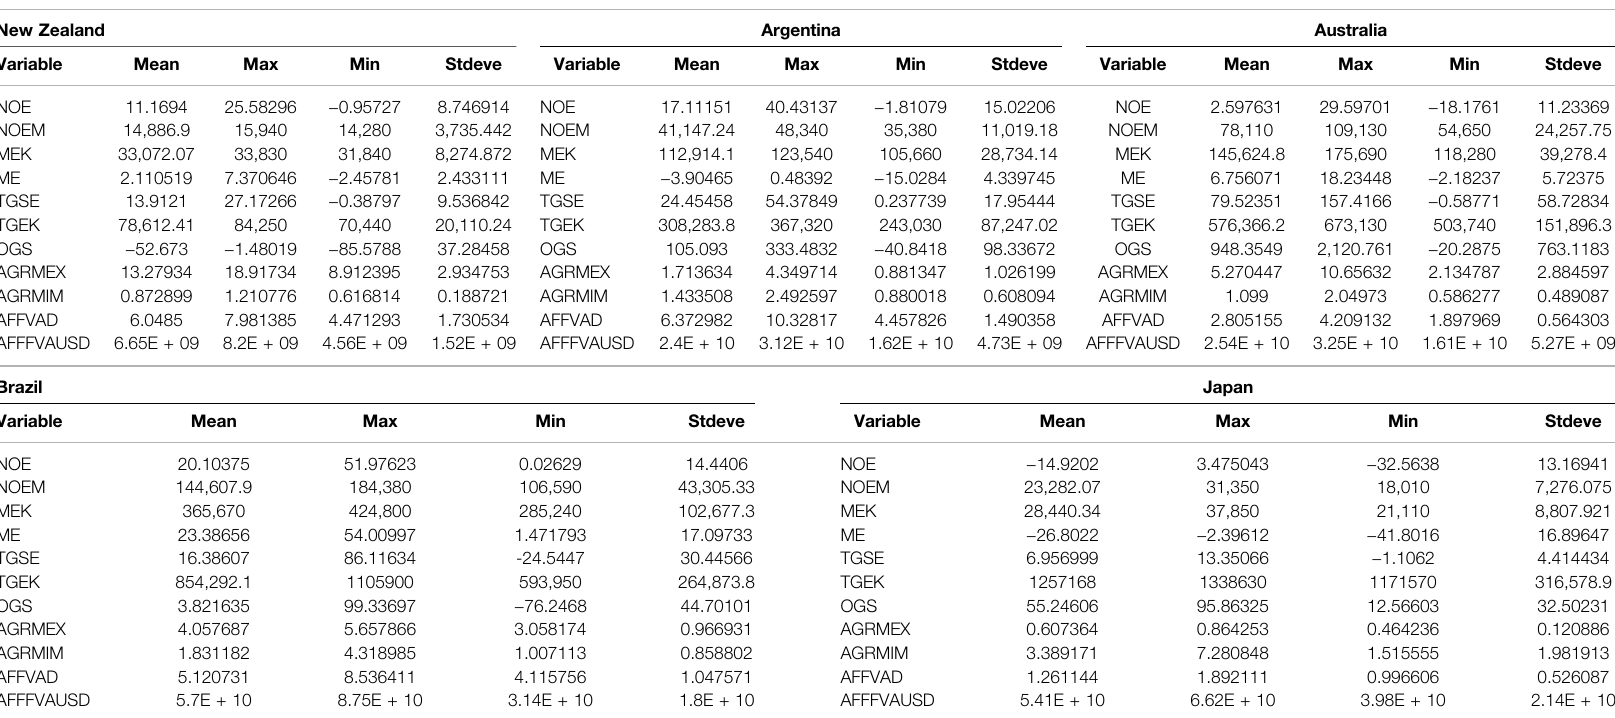
TABLE 1 | Data of different variables collected from 1990 – 2018 for followed countries. New Zealand